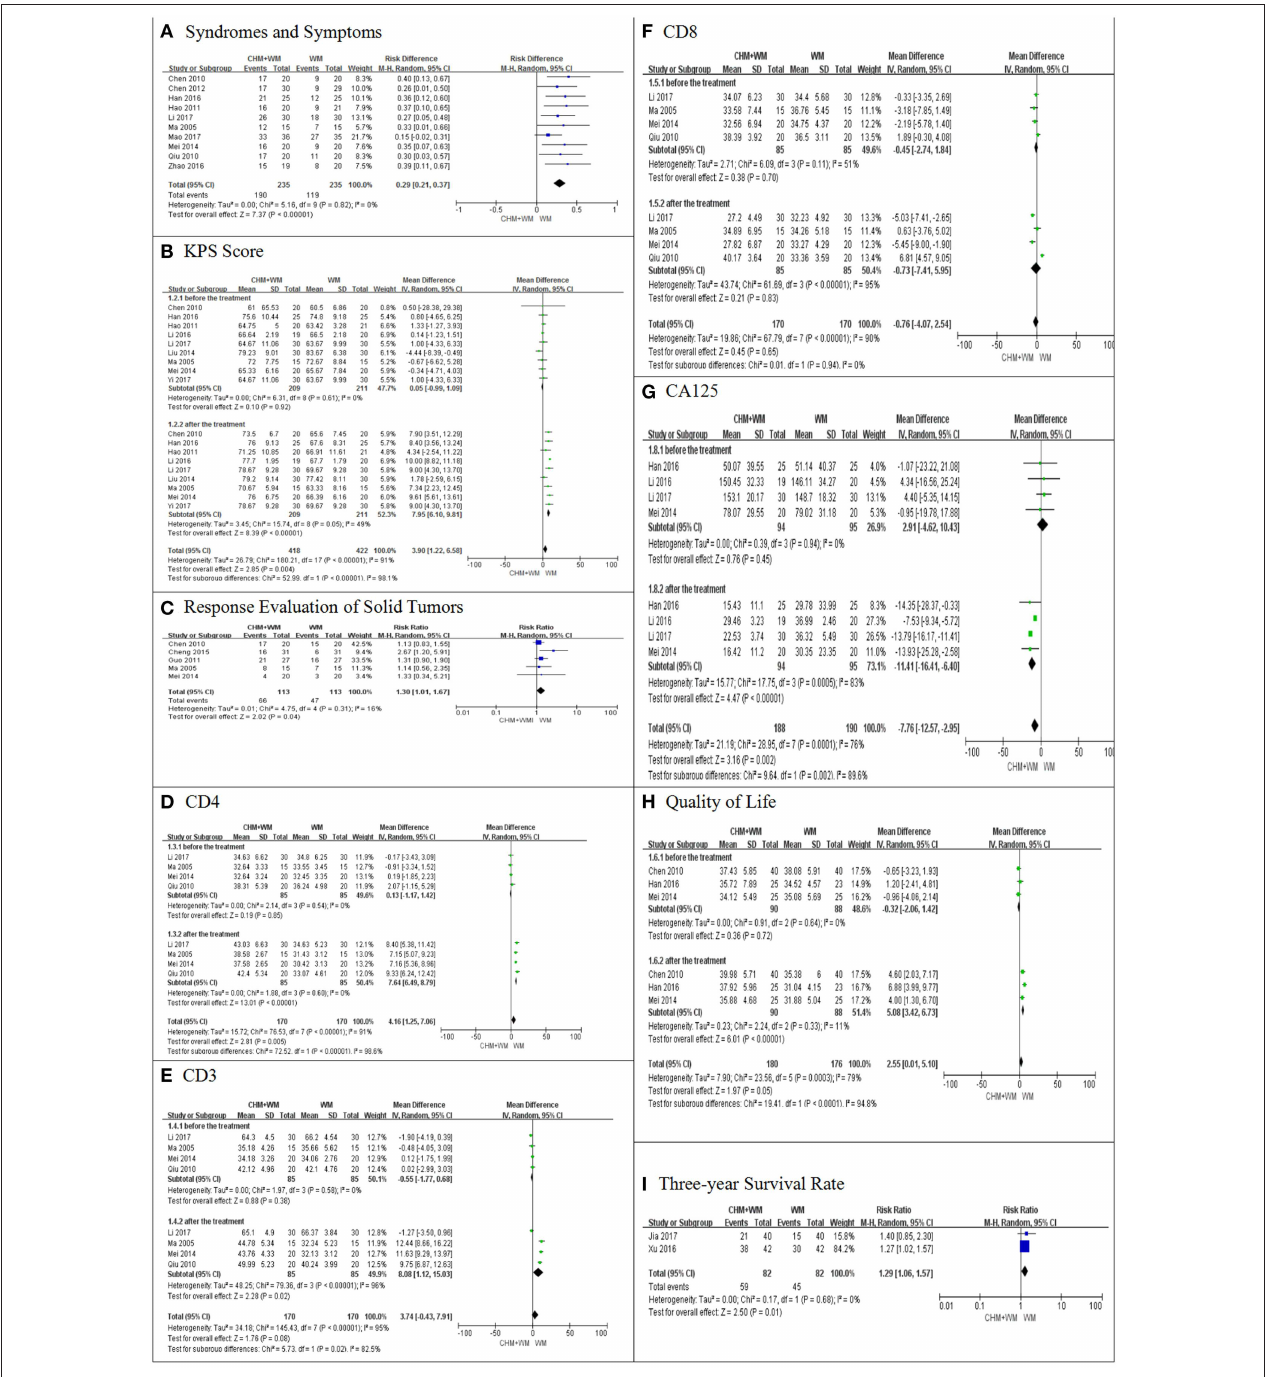
FIGURE 2 | Meta-analysis on efficacy. (A–I) showed the comparisons and meta-analyses on efficacy between CHM-WM group and WM group. The I2 statistic described the percentage of total variation across studies that was due to heterogeneity rather than chance. CI indicated the confidence interval. Dichotomous data were presented as pooled Risk Ratio (RR) with 95% confidence intervals (95% CIs), while continuous data were presented as Mean Difference (MD) with 95%